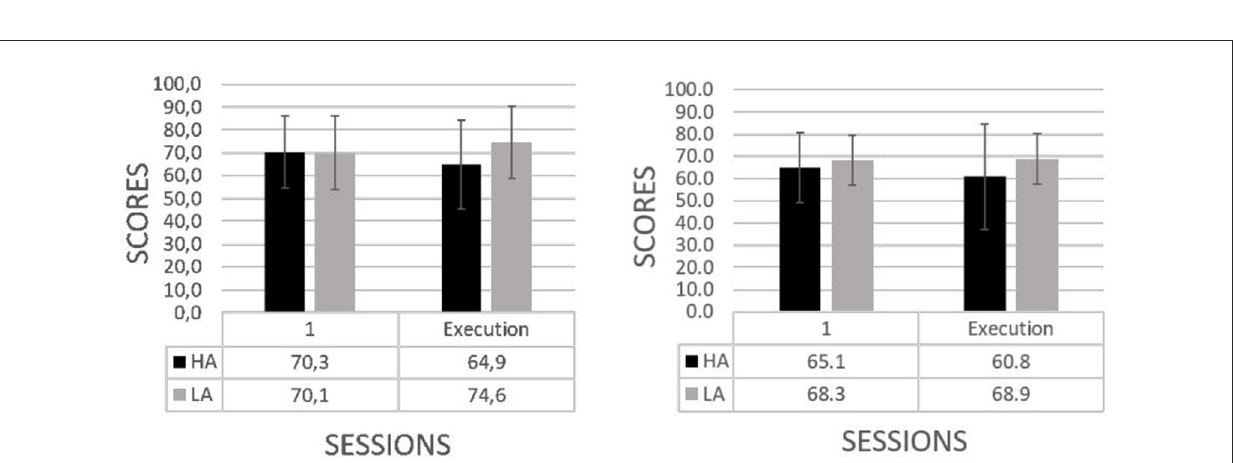
FIGURE9 Mental workload (mean and standard deviations) in the first session of training and the execution of the trained task by abstraction level: high (HA) vs. low (LA) in the cognitive (left) and motor (right)